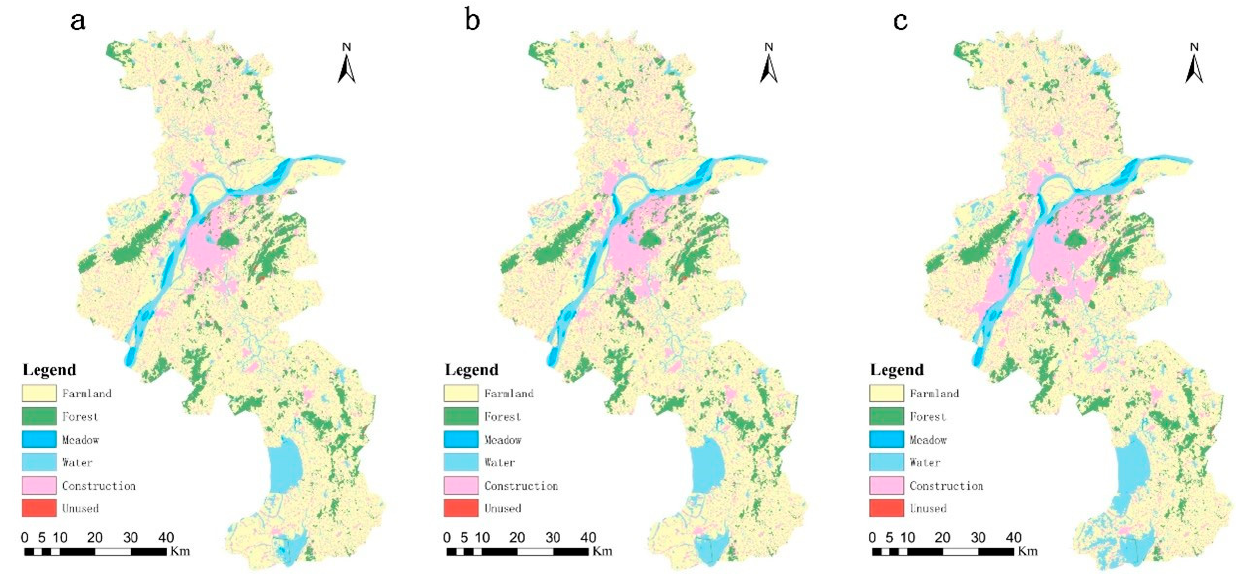
Figure 2. LU data in the years of ( a ) 1995, ( b ) 2000, and ( c ) 2005. The road network, digital elevation model (DEM), and the master plan of Nanjing city are also employed to analyze and model the LUC’s driving factors. The road network published by National Earth System Science Data Center contains different roads, including railway, national highway, highway, and county and town roads. This dataset is adopted to analyze the relationship between the distance to different level roads and LUC. The master plan of Nanjing city (1991–2010), officially published by the Nanjing Urban Planning Administration Bureau, can generate different-level city/county centers, farmland protection, and habitat conservation areas for further analysis. SRTM DEM is utilized to calculate the slope and verify its impacts on